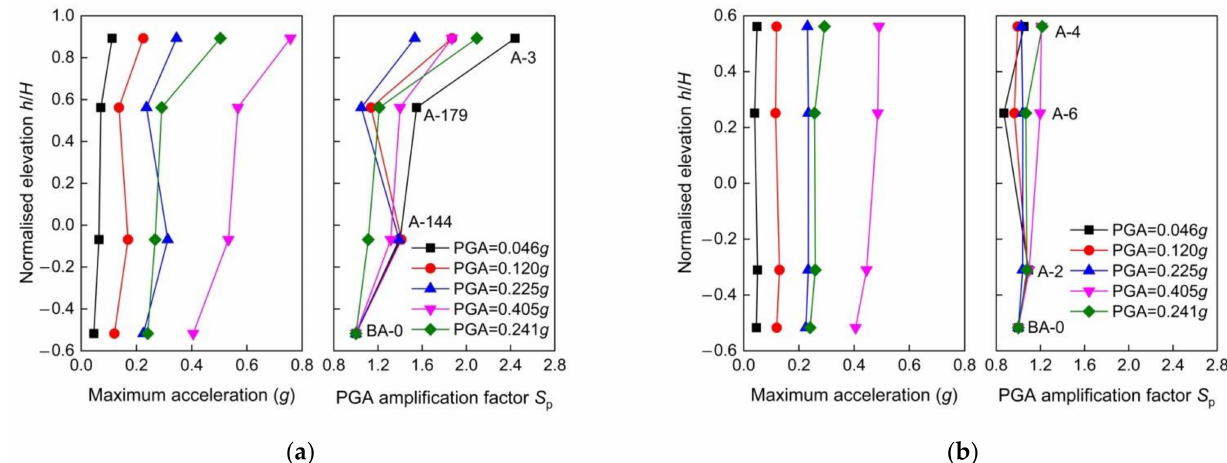
Figure 3. Maximum acceleration distributions along the normalized slope elevation in the 1# model in centrifuge tests: ( a ) deposit surface; ( b ) bedrock surface.